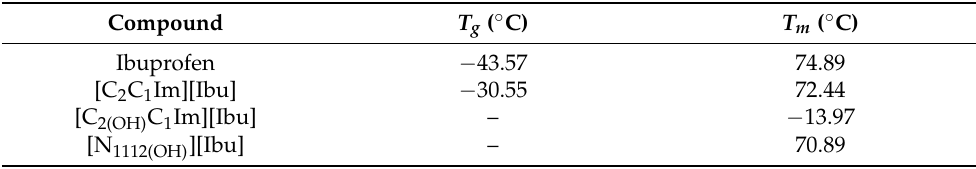
Table 3. Glass transition temperatures ( T g ) and melting temperatures ( T m ) of ibuprofen and ibuprofen-based ILs determined by DSC at a heating rate of 1 °C/min.